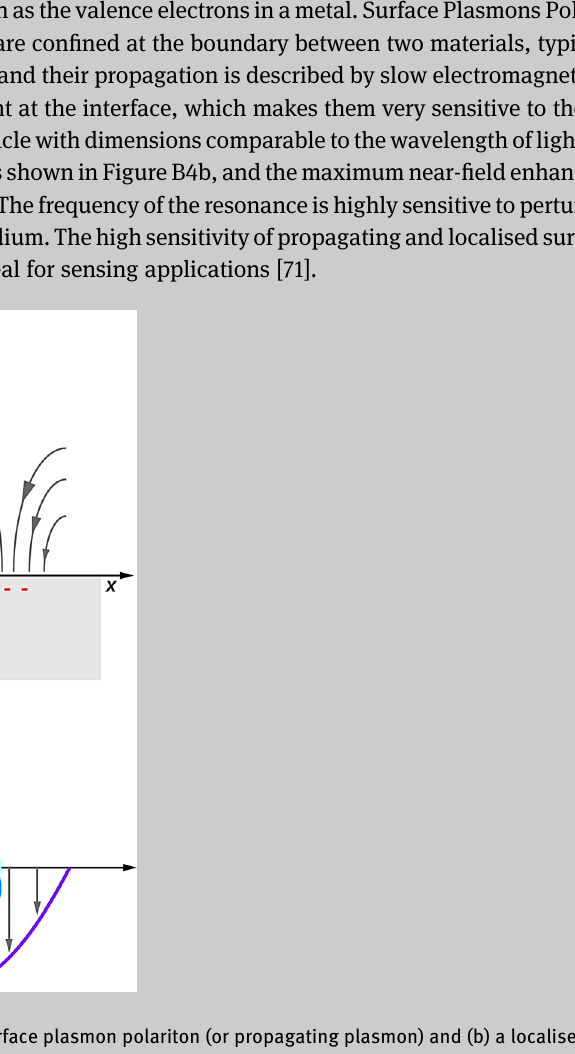
Figure B4: Schematic diagrams illustrating (a) a surface plasmon polariton (or propagating plasmon) and (b) a localised surface plasmon. Adapted from the study by Willets and Van Duyne